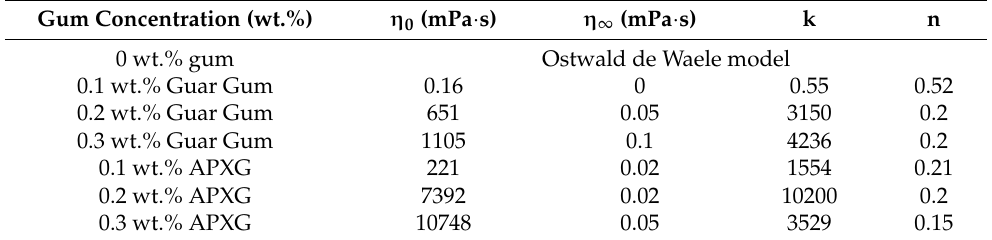
Table 2. Fitting parameter for linseed oil emulsions as a function of gum type and gum concentration. Gum Concentration